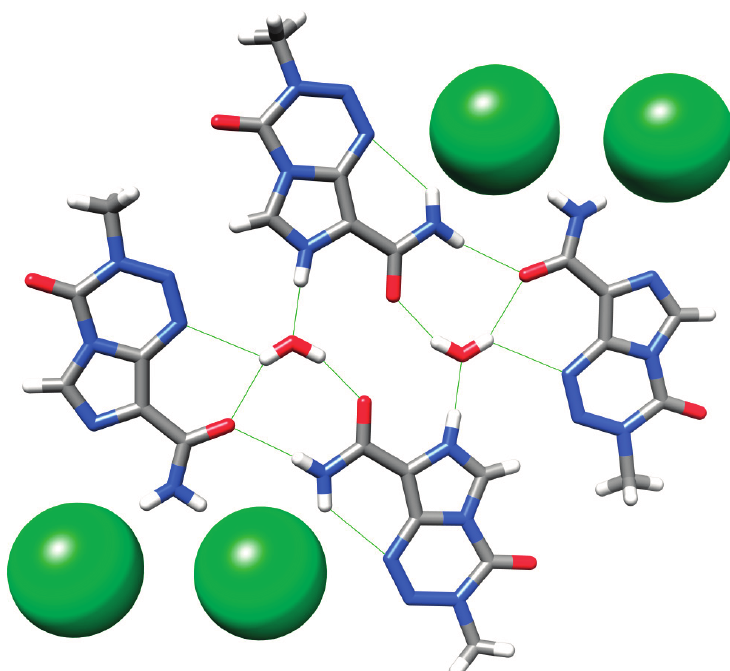
Figure 9. A tetrameric unit of TMZ in the crystal structure of TMZ·HCl·2H H-bonds are shown in green.